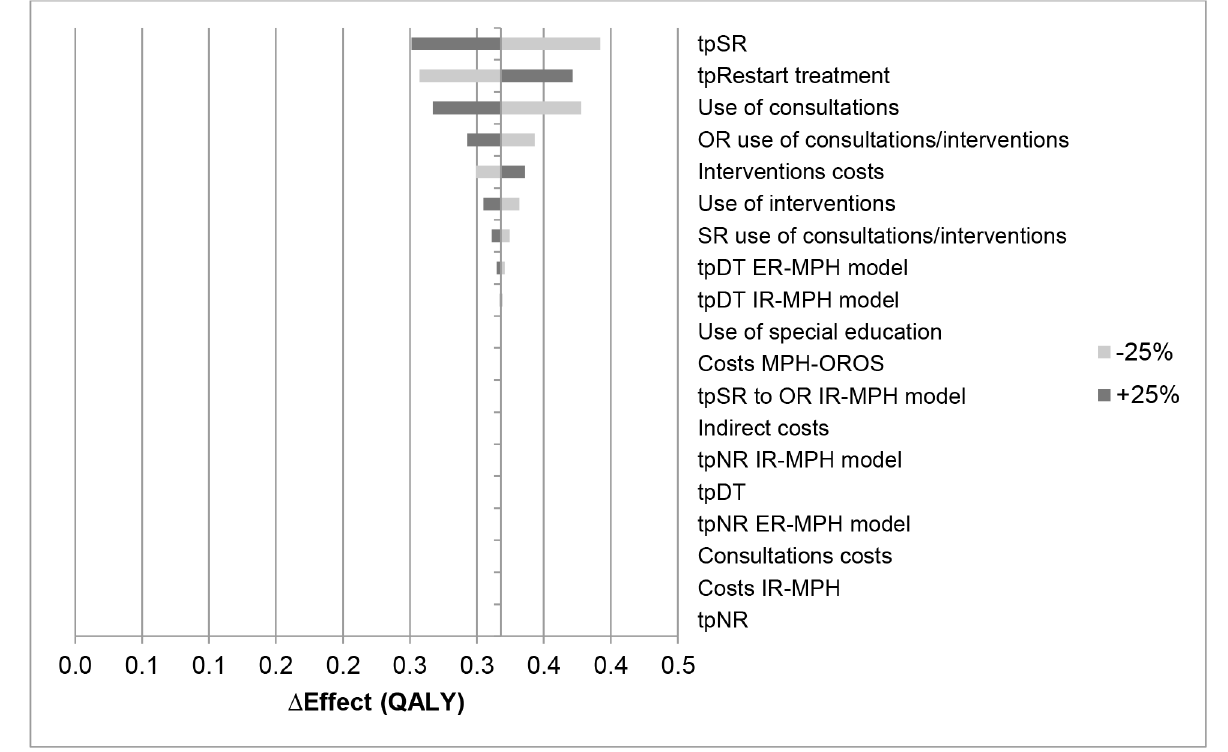
Fig 6. Effect of the univariate sensitivity analyses on the outcome of effect (QALY) (IR-MPH vs ER-MPH). Illustrative result for ER-MPH, example of MPH-OROS. tp = transition probability, SR = suboptimal response, OR = optimal response, DT = discontinuing treatment, NR = natural remission, IR-MPH = immediate release methylphenidate, ER-MPH = extended release methylphenidate.